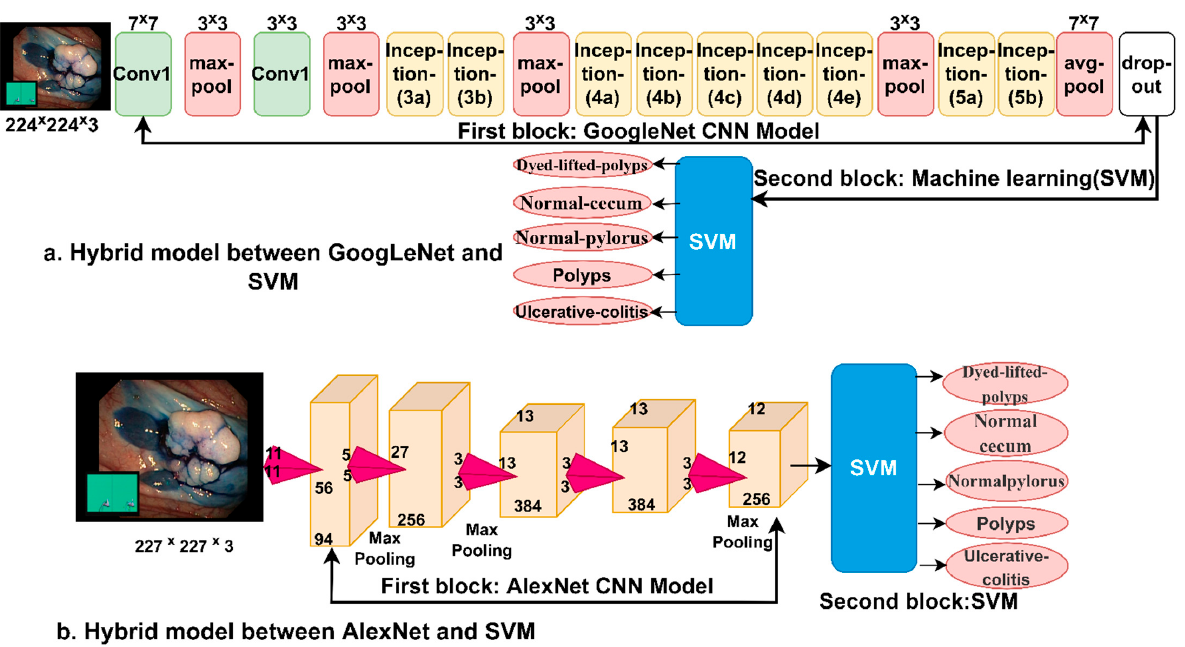
Figure 8. The general structure of the hybrid method between CNN models and SVM ( a ) GoogleNet+SVM and ( b ) AlxNet+SVM.